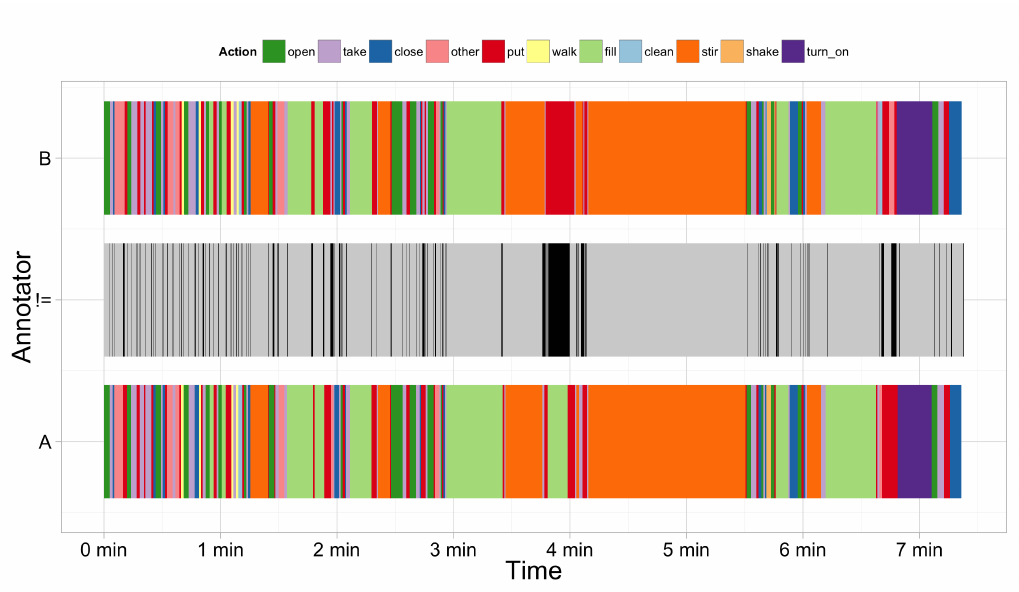
Figure 6. Comparison between the annotation of a video log of Annotator A (bottom) and Annotator B (top) from the “Brownie” dataset for subject 9. The different colours indicate different action classes. The plot in the middle illustrates the differences between both annotators (in